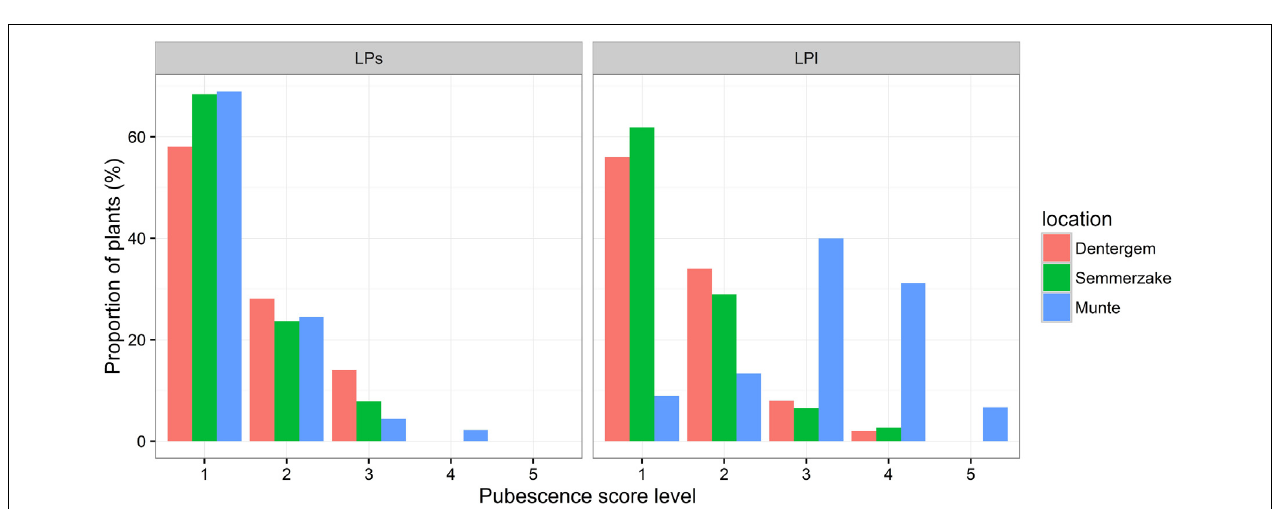
FIGURE 3 | Proportion of shrubs in the different leaf pubescence score levels in the three plantations. Dentergem and Semmerzake comprise clonal plants from P. spinosa whereas Munte comprises families (half sib seedlings) from P. spinosa – P. x fruticans . Trait abbreviations are in Table 2